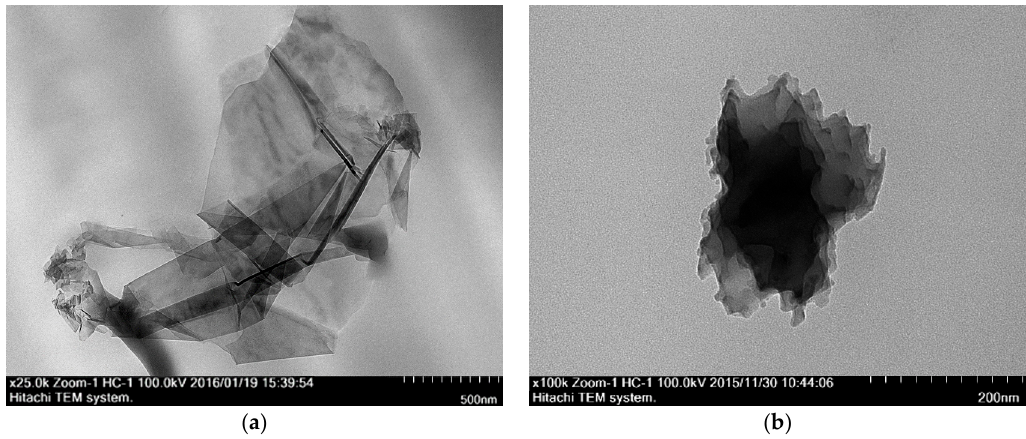
Figure 14. Cross section TEM images of nanocomposites prepared by in situ polymerization with different RGO loading. ( a ) 0.5 wt % RGO loading; ( b ) 2.0 wt % RGO loading.